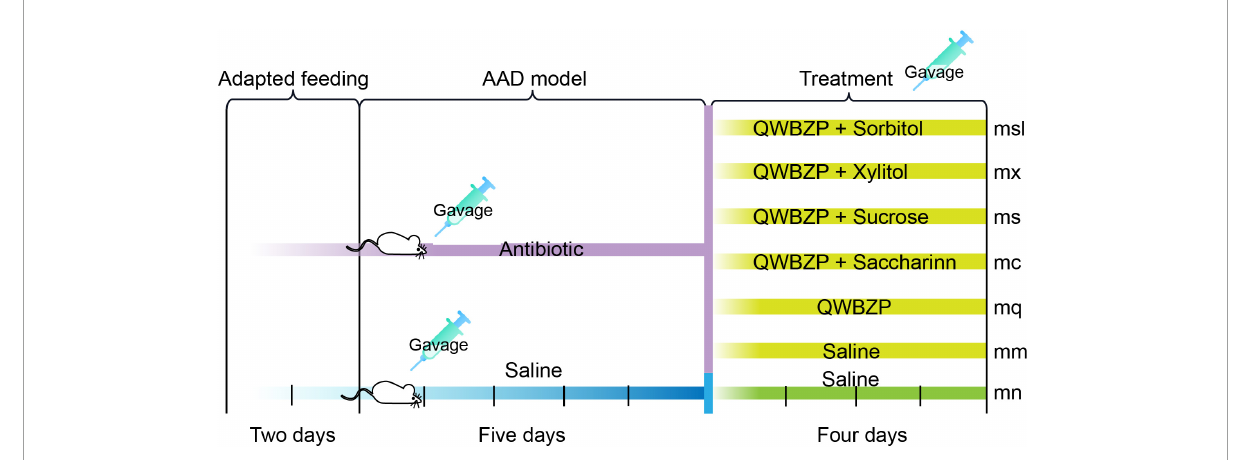
FIGURE2 Experimental design and general conditions of the animals. mn, Control group; mm, Model group; mq, QWBZP group; ms, QWBZP + Sucrose group; mc, QWBZP + Saccharinn group; mx, QWBZP + Xylitol group; msl, QWBZP + Sorbitol group.